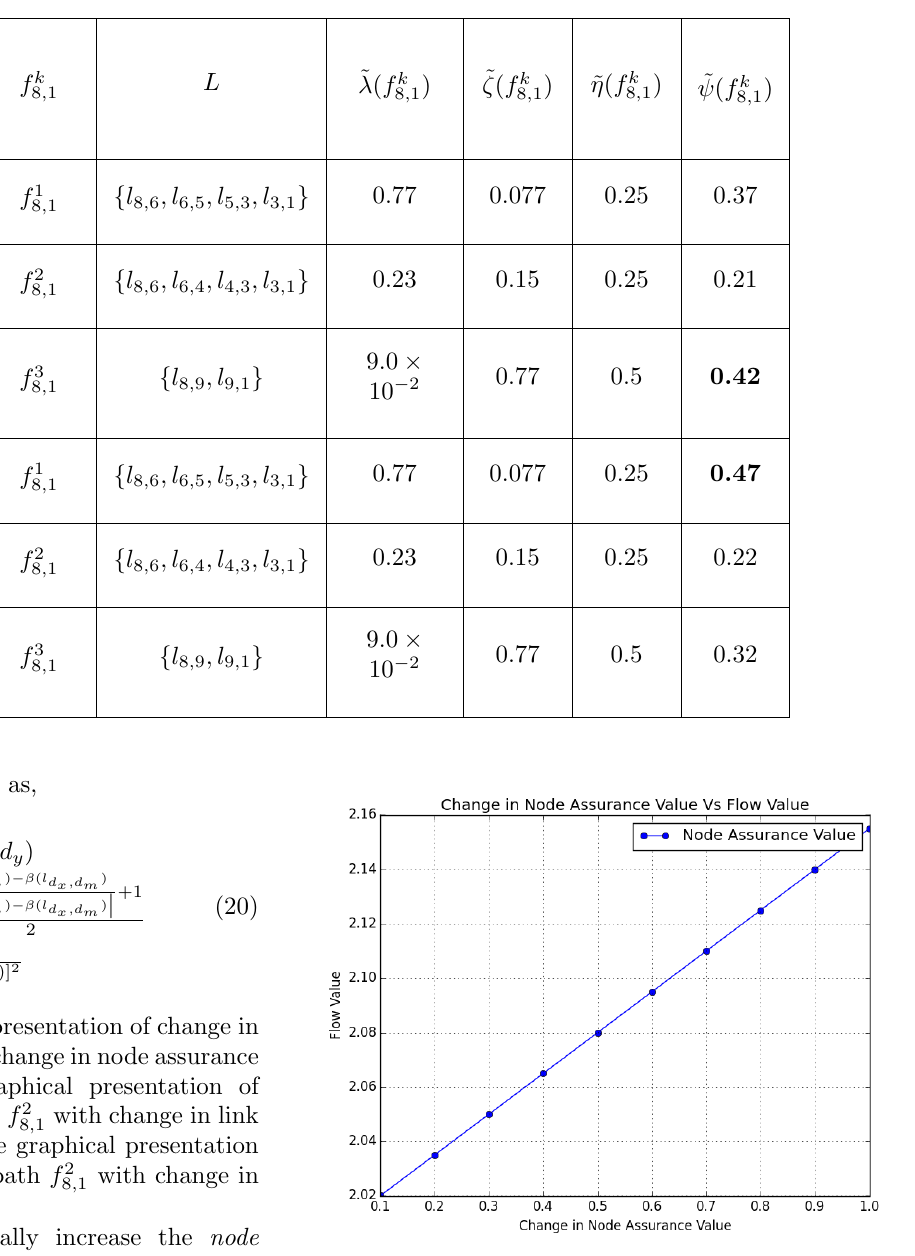
Figure 3. Change in Flow Value with change in Node Assurance